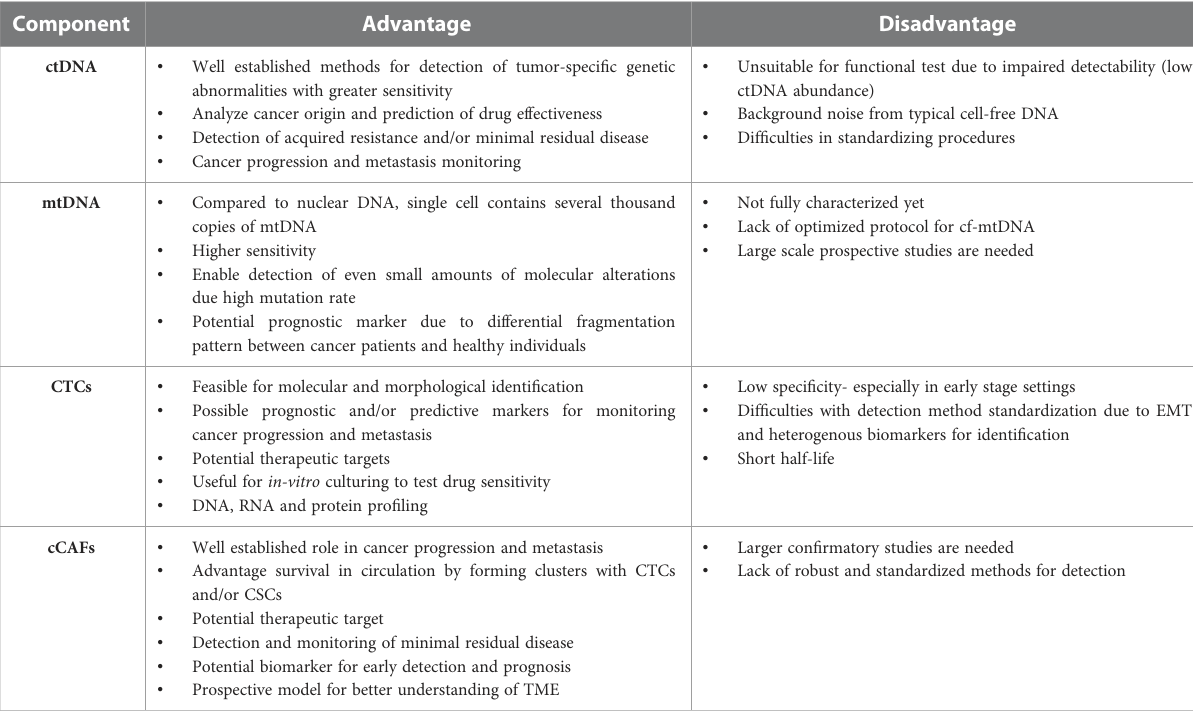
TABLE 5 Advantages and disadvantages of liquid biopsy